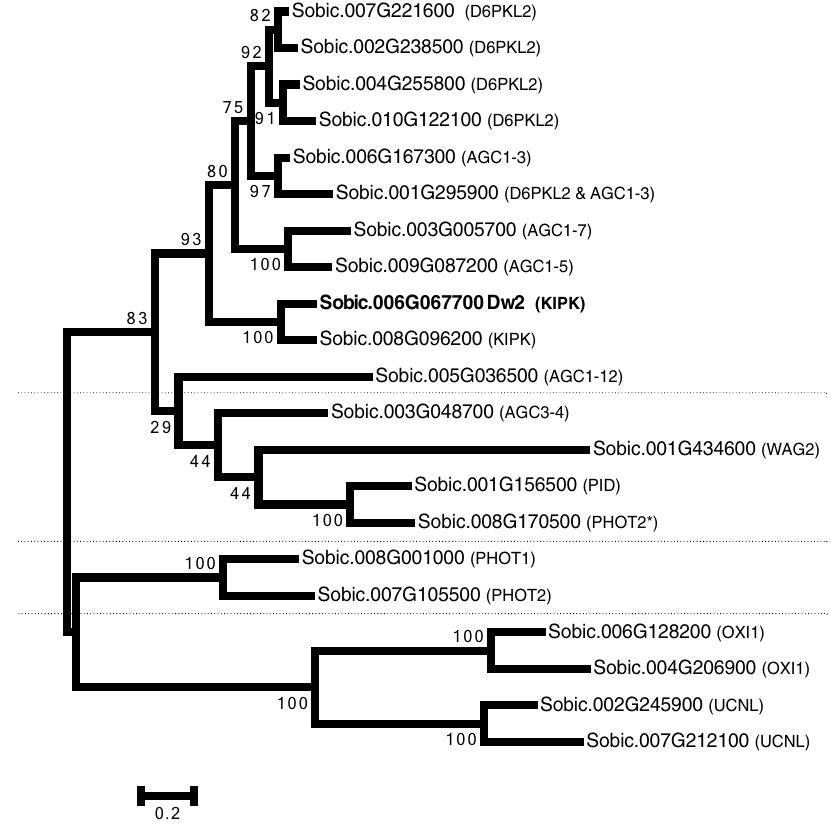
Figure 4. Phylogenetic tree of the AGCVIII subfamily in sorghum. The tree of the 21 sorghum AGCVIII genes was generated in MEGA6 using Maximum Likelihood. Dw2 is bolded. The four different groups, AGC1-4, are labeled and colored. The names in parenthesis are the best hit from a BLAST search of the Arabidopsis genome using that sorghum gene as a query. * The best hit for Sobic.008G170500 is PHOT2 but the score is much lower than Sobic.007G105500 to PHOT2 (203.4 vs. 1122.1 for the Dual Affine Smith Waterman alignment score). Further, Sobic.008G170500 is the best BLAST match of the maize PID homolog, BARREN INFLORESCENCE2, in